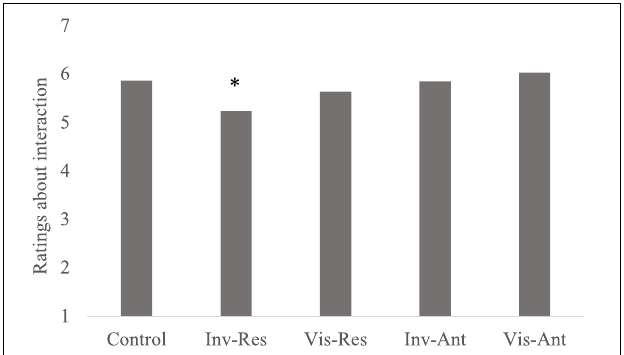
FIGURE 4 | Means for ratings about service interaction ratings in Study 5. * p <